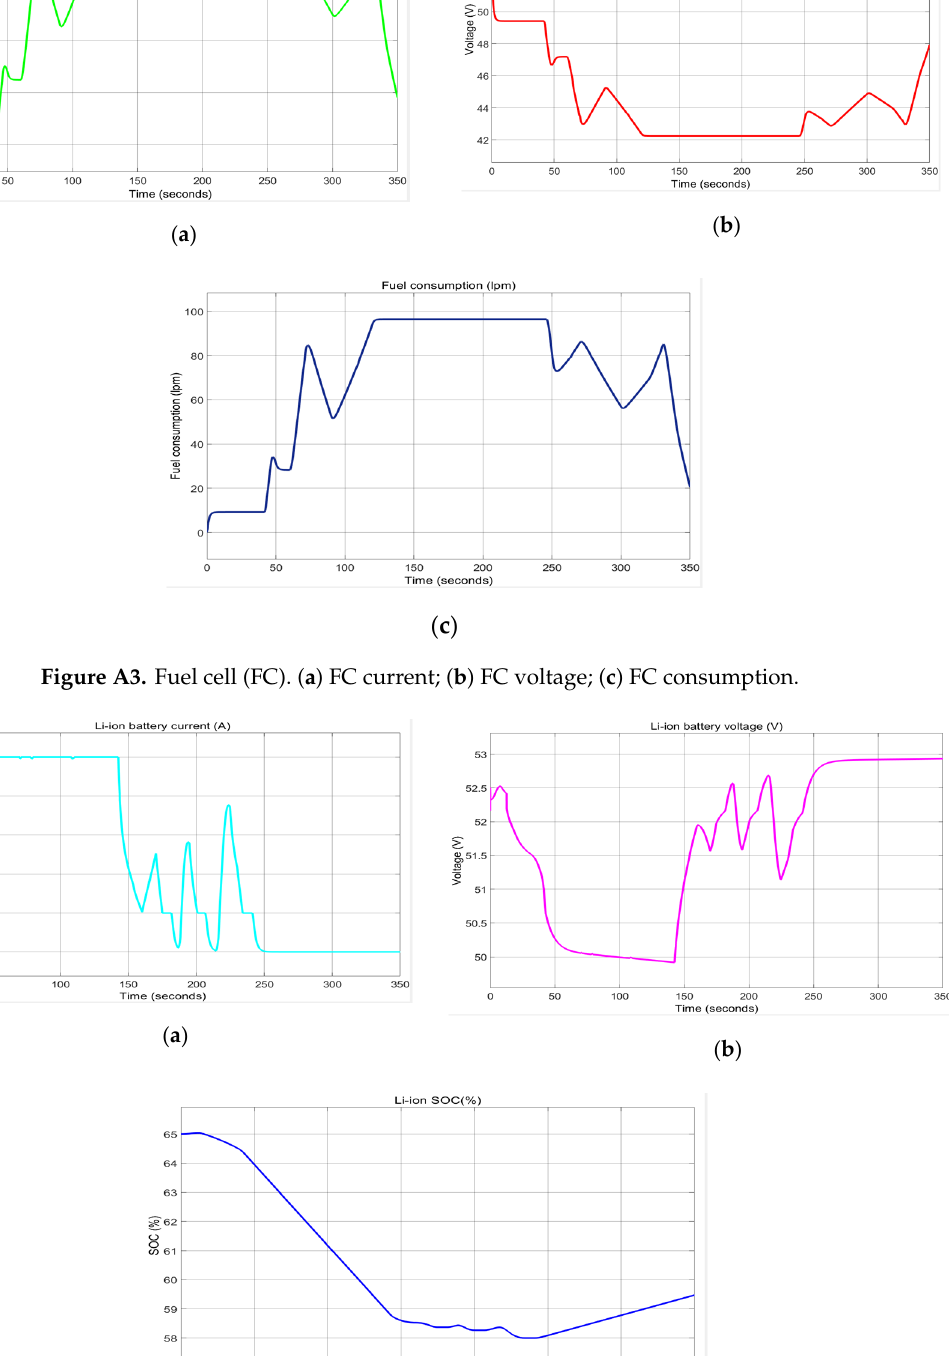
Figure A4. Li-ion battery specific variables. ( a ) Battery current; ( b ) battery voltage; ( c ) battery SOC.